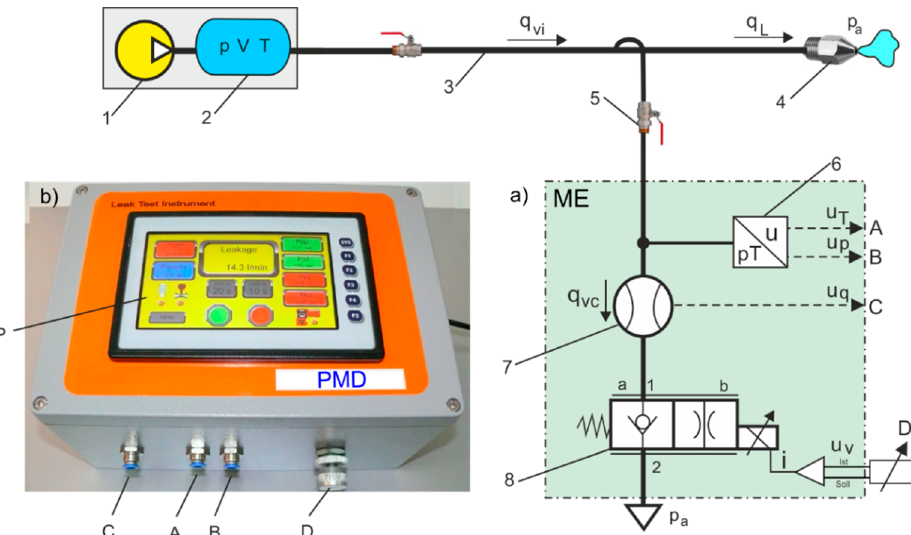
Figure 7. Schematic diagram of a measuring system for indirect leakage measurement on a branch of the pipeline: 1—compressor station, 2—air receiver tank, 3—air pipeline, 4—symbolic of the